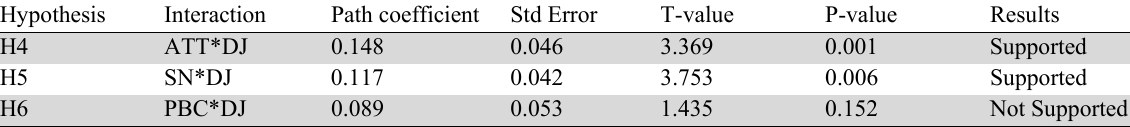
Moderation Effects of Distributive Justice